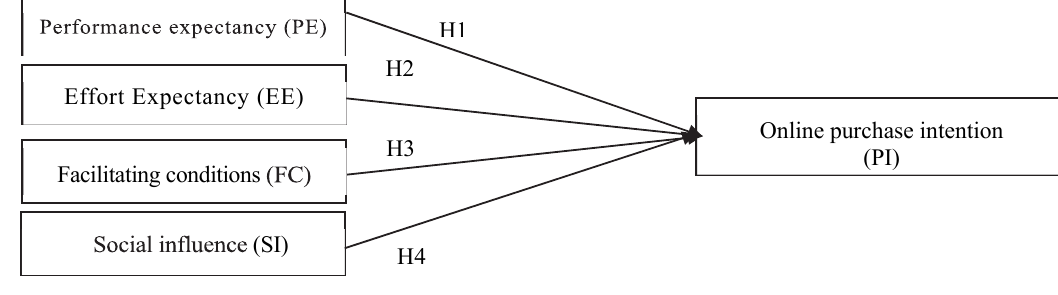
Fig. 1. Proposed theoretical